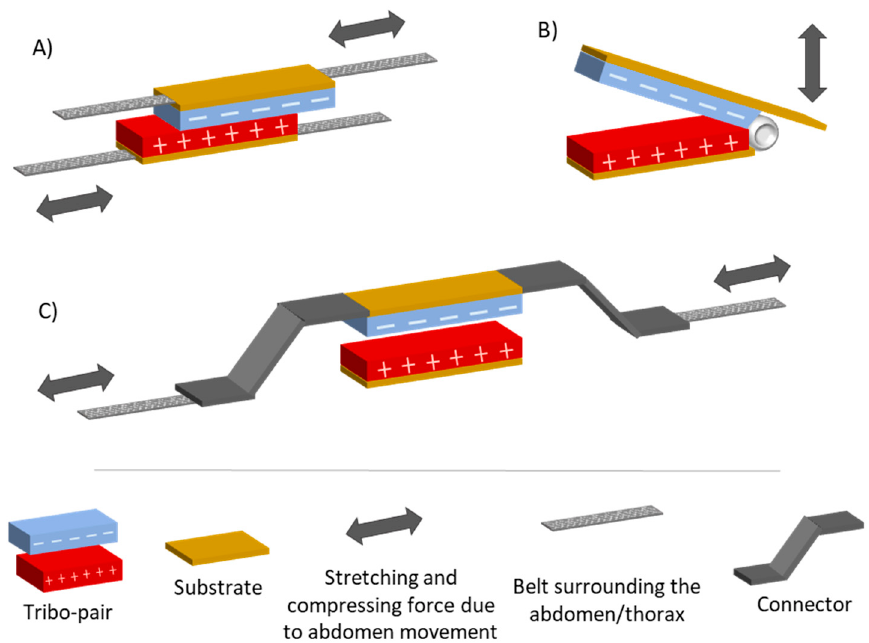
Figure 15. Setups for triboelectric energy harvesting. Three possible configurations are shown: ( A ) flat belt-attached setup (figure inspired by Reference [246]), ( B ) Z-shaped connector (figure inspired by Reference [77]), and ( C ) movable and fixed supports (figure inspired by Reference [247]).